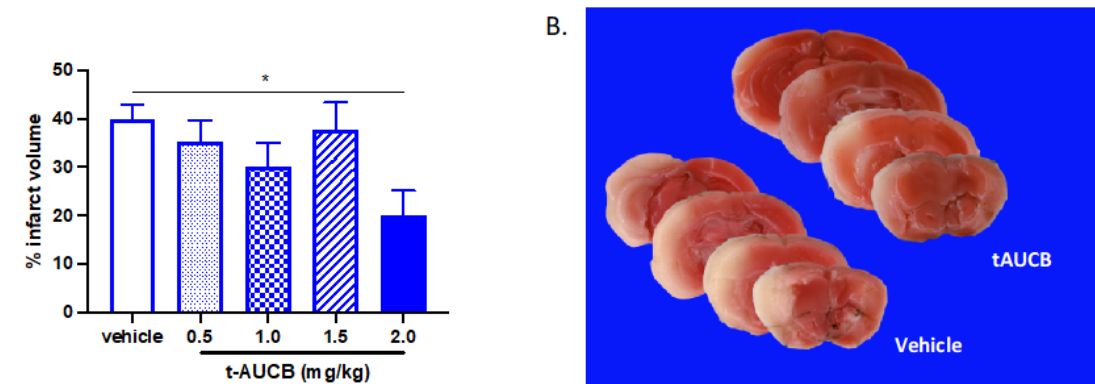
Figure 1. tAUCB administration at reperfusion reduces infarct volume. Mice were given 0.5, 1.0, 1.5 or 2.0 mg/kg tAUCB i.p. at the time of vessel reperfusion, hemispheric infarct was assessed 24 h later by TTC. ( A ) The highest dose tested, 2.0 mg/kg, reduced infarct (* p < 0.05, 2.0 mg/kg vs. vehicle); lower doses of tAUCB did not significantly affect infarct volume. n = 4–7/group. ( B ) Representative TTC images coronal brain sections from mice treated with 2.0 mg/kg tAUCB